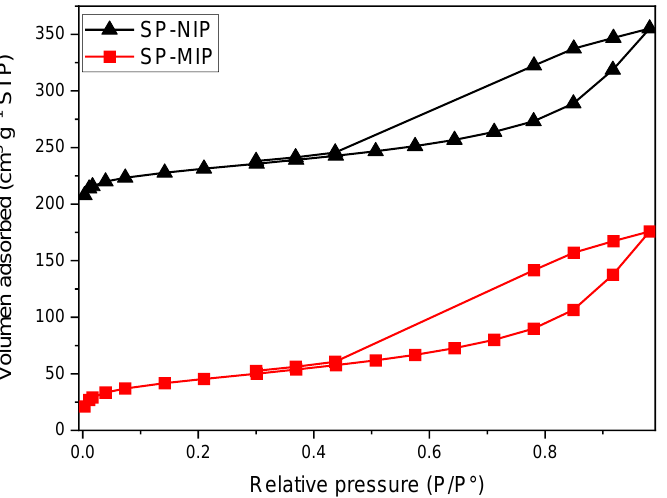
Figure 3. N 2 adsorption-desorption isotherms for superparamagnetic imprinted polymer (SP-MIP) and superparamagnetic non-imprinted polymer SP-NIP. Table 2. BET surface area and porosity obtained for the SP-MIP and SP-NIP materials. Sample